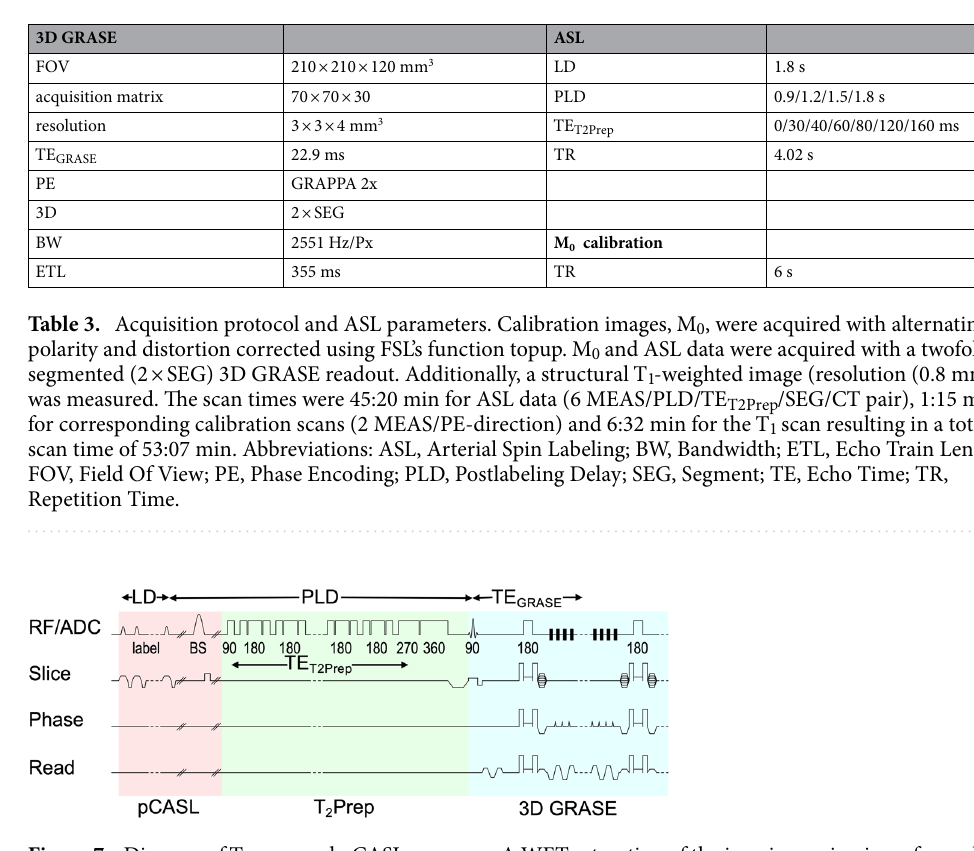
Figure 7. Diagram of T 2 prepared pCASL sequence. A WET saturation of the imaging region is performed before pCASL labeling. Three background suppression (BS) pulses are timed to suppress static tissue signal. Only a single BS pulse is shown for clarity. The pulses may intersperse with the labeling pulses and thus interrupt the pCASL labeling but not the T 2 preparation which is played out immediately before the 3D GRASE readout. In case of an interruption the label condition is changed between tag and control. In order to induce different T 2 weightings, TE T2Prep , the preparation module is composed of non-selective pulses arranged in three different Malcolm Levitt (MLEV) cycling schemes with 4 ( TE T2Prep = 30/40 ms), 8 ( TE T2Prep = 60/80 ms) and 16 ( TE T2Prep = 120/160 ms) composed refocusing pulses as well as a composed 270°-360° tip-up pulse to compensate for off-resonance effects and B 1 imperfections. Abbreviations: ADC, Analog-To-Digital Conversion; BS, Background Suppression; LD, Labeling Duration; pCASL, Pseudocontinuous Arterial Spin Labeling; PLD, Postlabeling Delay; RF, Radio Frequency (Transmission); TE, Echo